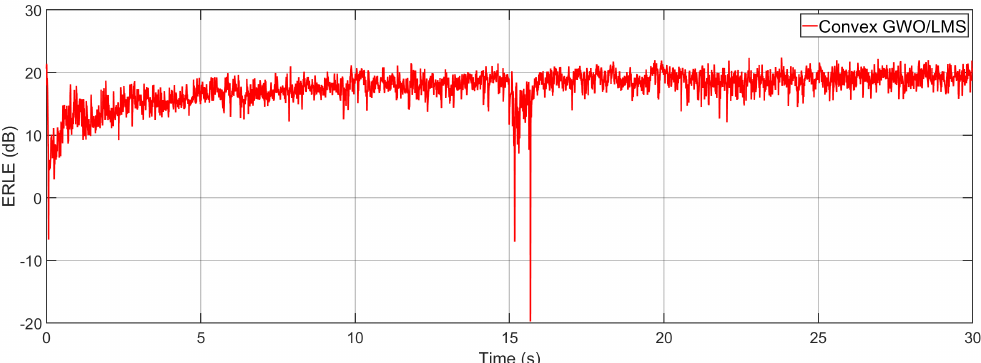
Figure 16. ERLE learning curve of the proposed convex GWO/LMS considering an AR(1) process as input signal and a double-talk scenario.